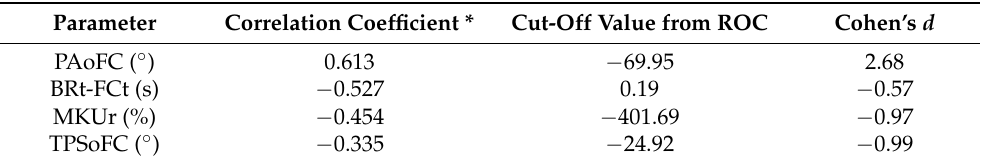
Table 4. Correlation coefficients and cut-off values from ROC of each parameter correlated with ball speed and their Cohen’s d effect sizes (sorted by absolute value of correlation coefficient in order of high to low). Parameter Correlation Coefficient * Cut-Off Value from ROC Cohen’s d PAoFC ( ◦ ) 0.613 − 69.95 2.68 BRt-FCt (s) − 0.527 0.19 − 0.57 MKUr (%) − 0.454 − 401.69 − 0.97 TPSoFC ( ◦ ) − 0.335 − 24.92 −